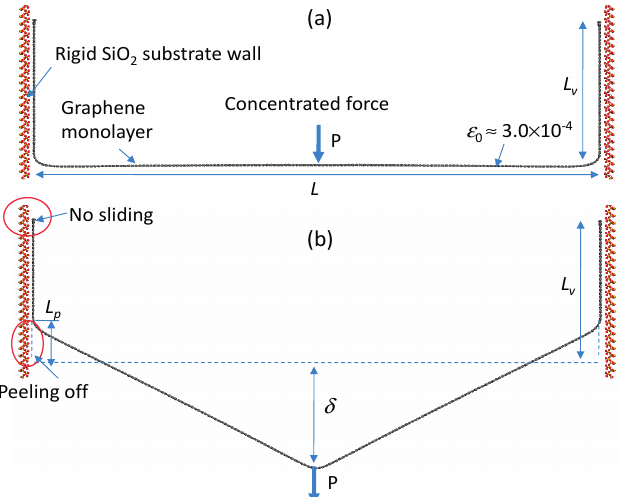
Figure 12. Computational model of graphene with the side wall vdW adhesion in